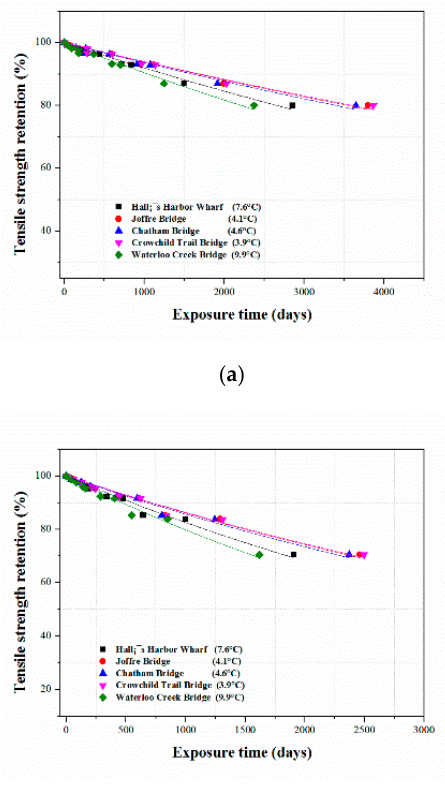
Table 7. Time-shift factor of CFRP composites at di ff erent annual temperature chosen.